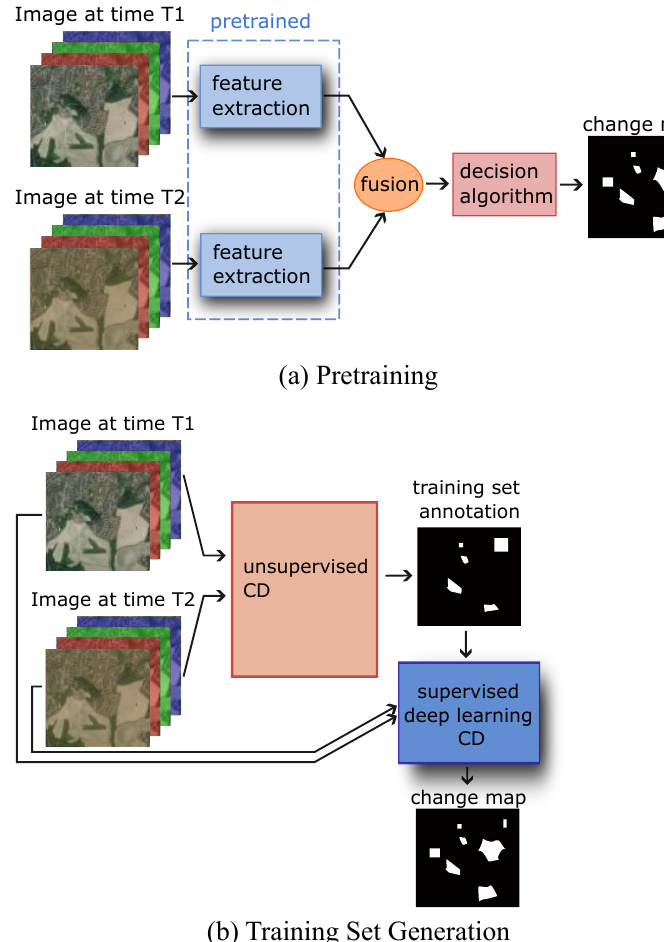
Figure 5. Two possible unsupervised network structures. ( a ) Network with pretrained feature extrac- tors. Siamese feature extractors that have been pretrained on a related task are used to automatically extract image features. The features are then input into an automatic decision algorithm that compares them and outputs a change map. ( b ) Using an unsupervised classical change-detection method to create a labelled training dataset for a supervised deep-learning-based CD